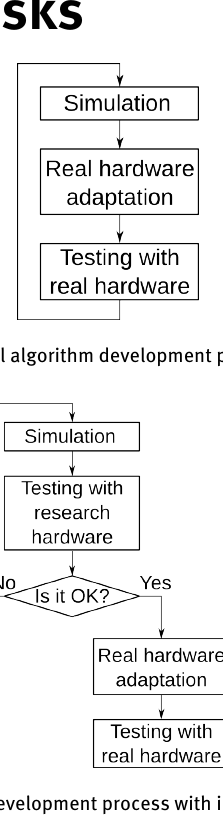
Figure 2: Algorithm development process with intermediate